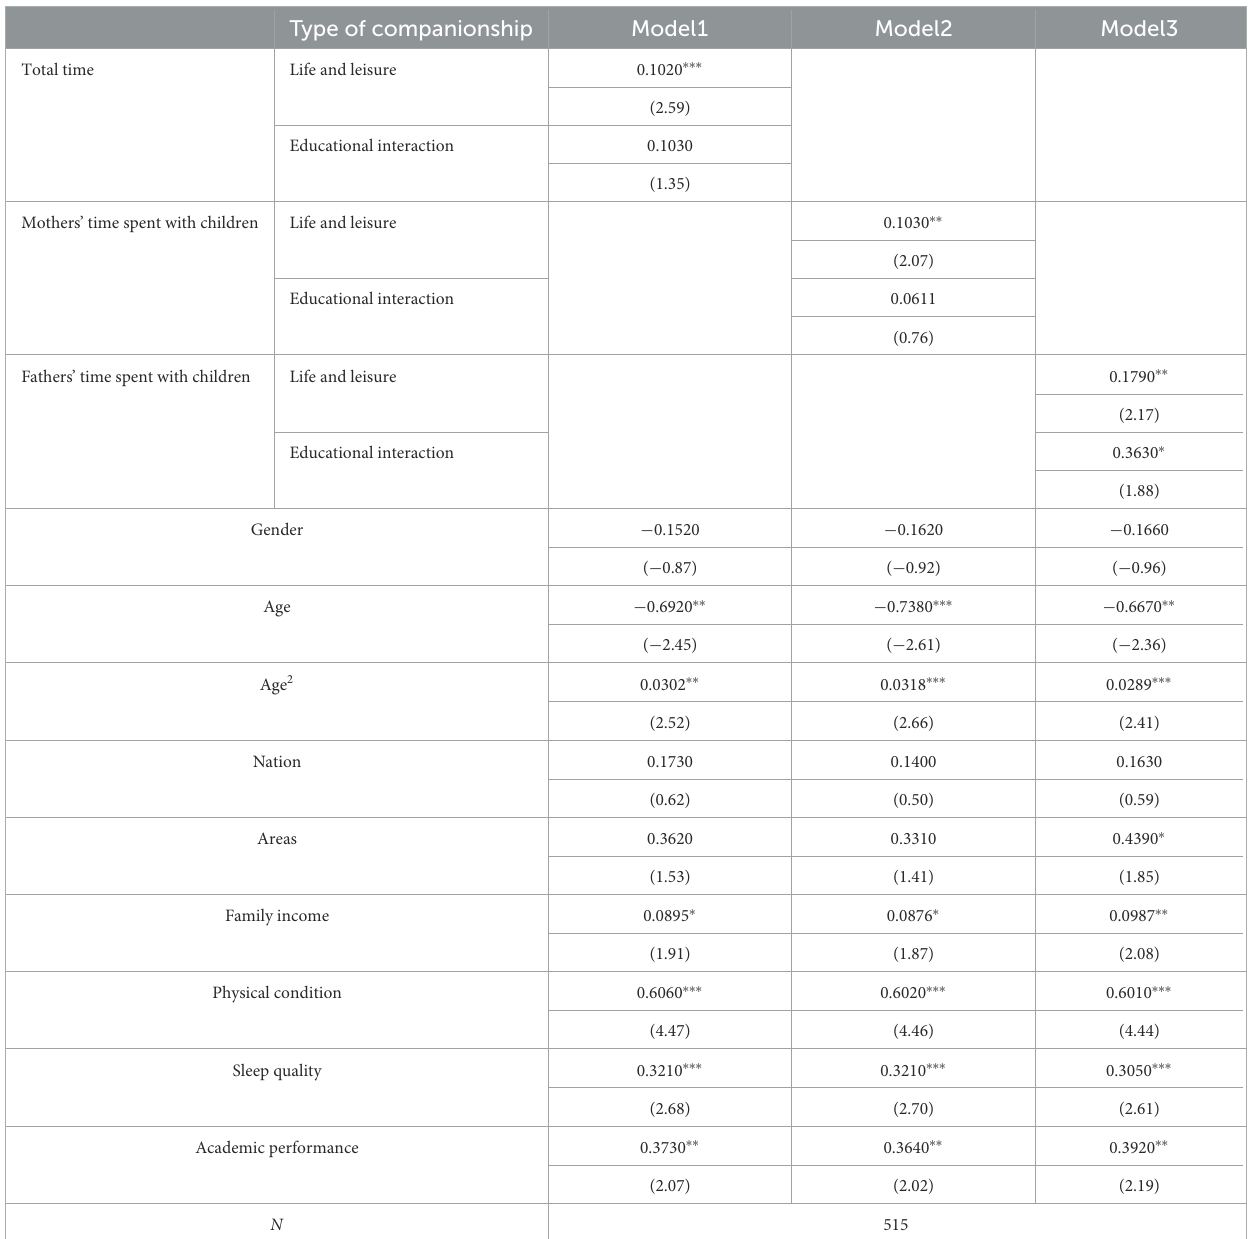
TABLE 6 Regression results of different types of companionship and parental division of labor on children’s